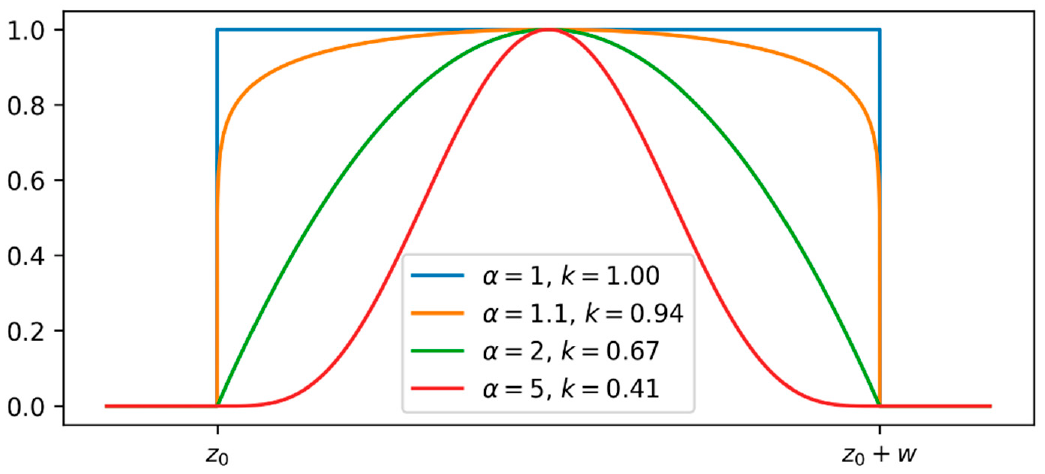
Figure 6. Examples of profiles p leak ( z ) obtained using model (9).